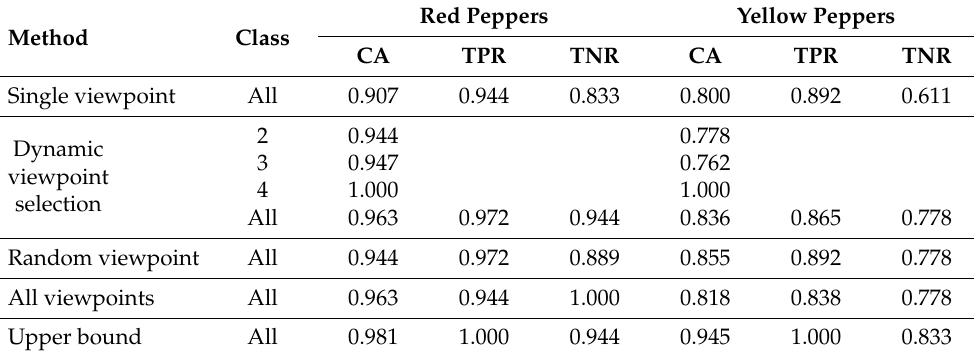
Table 3. Classification accuracy (CA), true positive rate (TPR), and true negative rate (TNR) for single viewpoint, dynamic viewpoint selection, random viewpoint selection, all viewpoints, and the upper bound. For dynamic viewpoint selection, the CA per class is also